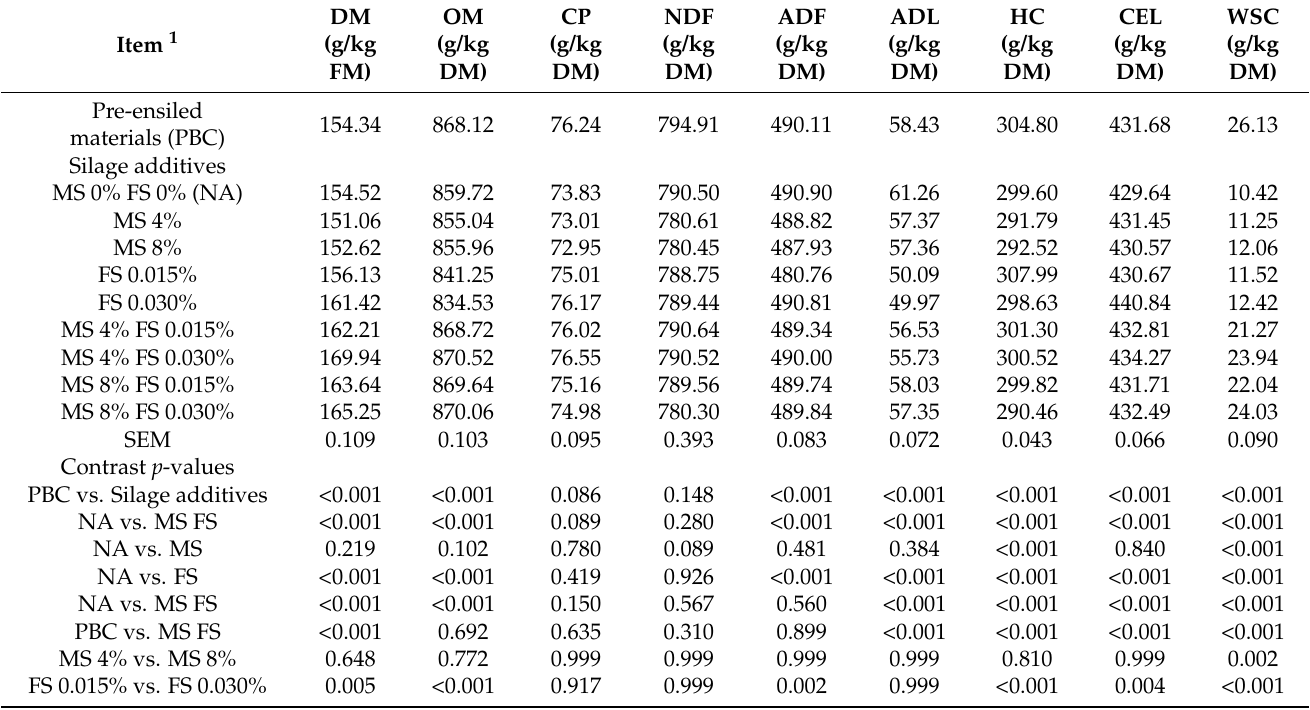
Table 1. Chemical composition of anthocyanin-rich black cane prior to ensiling (pre-ensiled materials) and its silages at 42 d after fermentation.